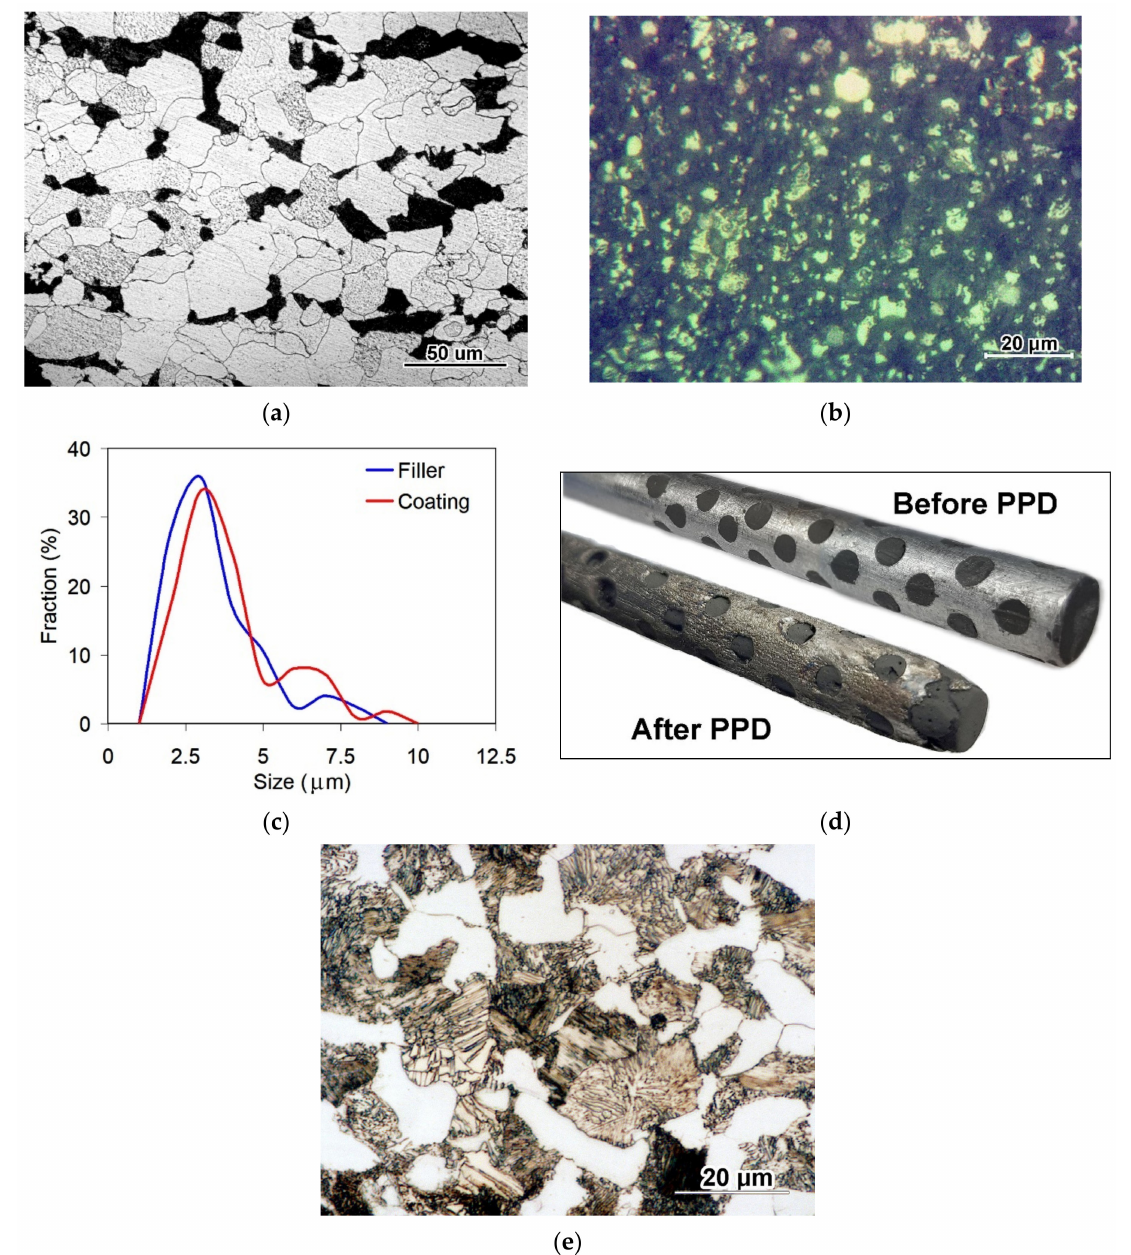
Figure 3. The consumable part of the EAPA cathode: the microstructure of ( a ) a steel tube and ( b ) a filler, ( c ) carbide size distributions for the filler and the coating, and ( d ) general view of the